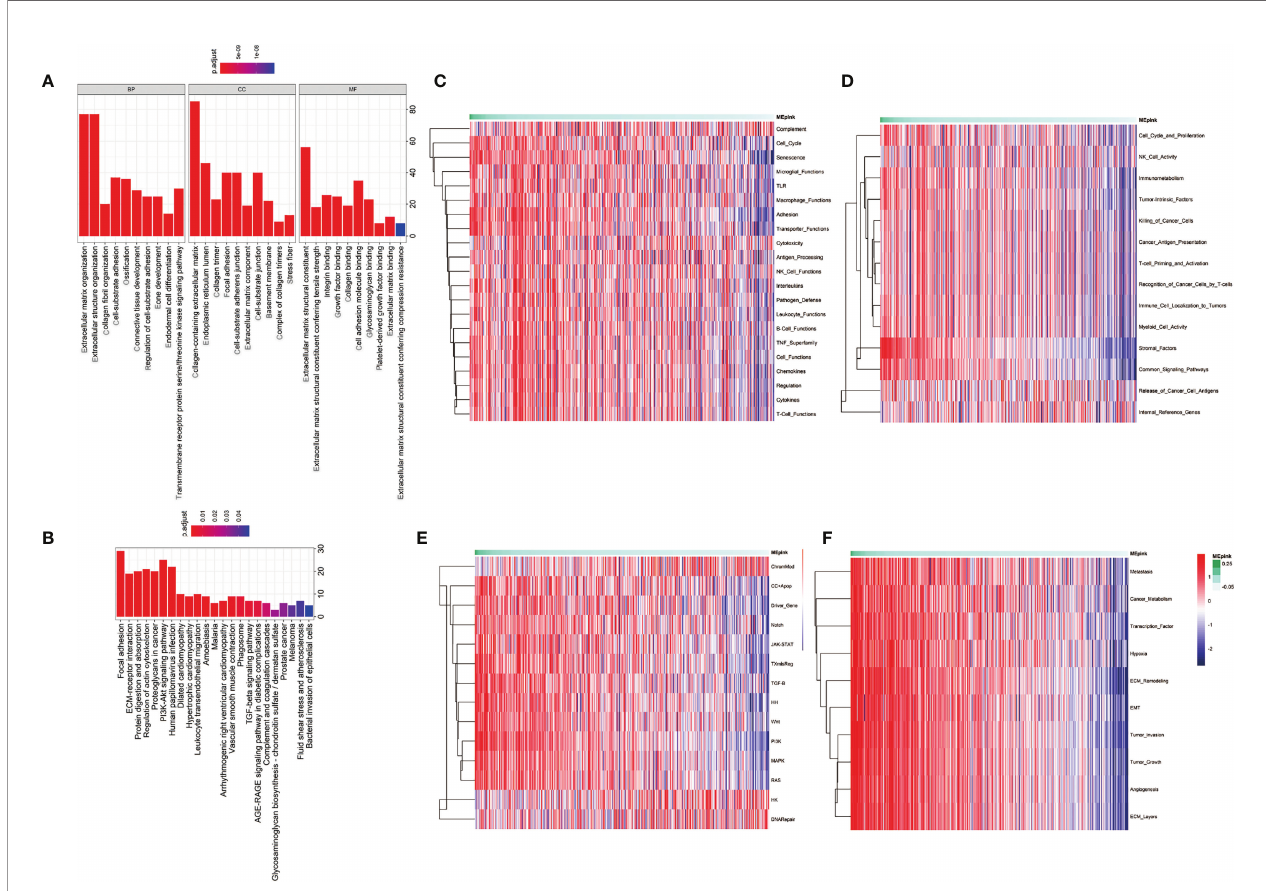
FIGURE 3 | Enrichment analysis of the signi fi cant genes in the pink module. (A) Gene ontology enrichment including biological process (BP), cellular component (CC), and molecular function (MF). (B) KEGG enrichment of signi fi cant genes in pink module. (C – F) Pathway enrichment of signi fi cant genes in pink module. (C) is the pathways that participate in immune pro fi ling. (D) is the pathways in IO.unity. (E) is the common pathways in human physiological process. (F) is the pathways of cancer